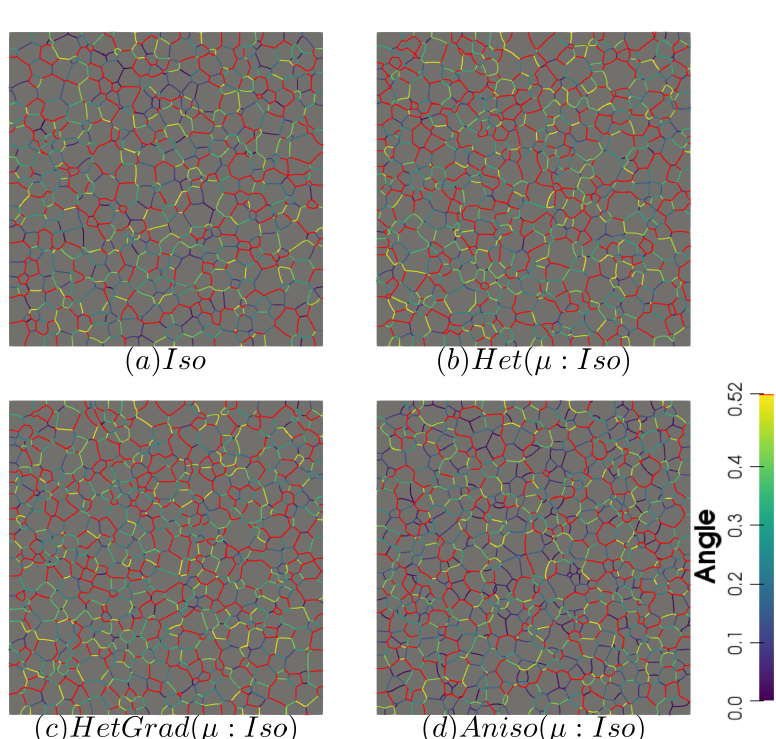
Figure A9. Disorientation of the boundaries using the four formulations with homogeneous grain boundary mobility at t = 1 h. Boundaries with a disorientation higher than 30 ◦ are colored in red.